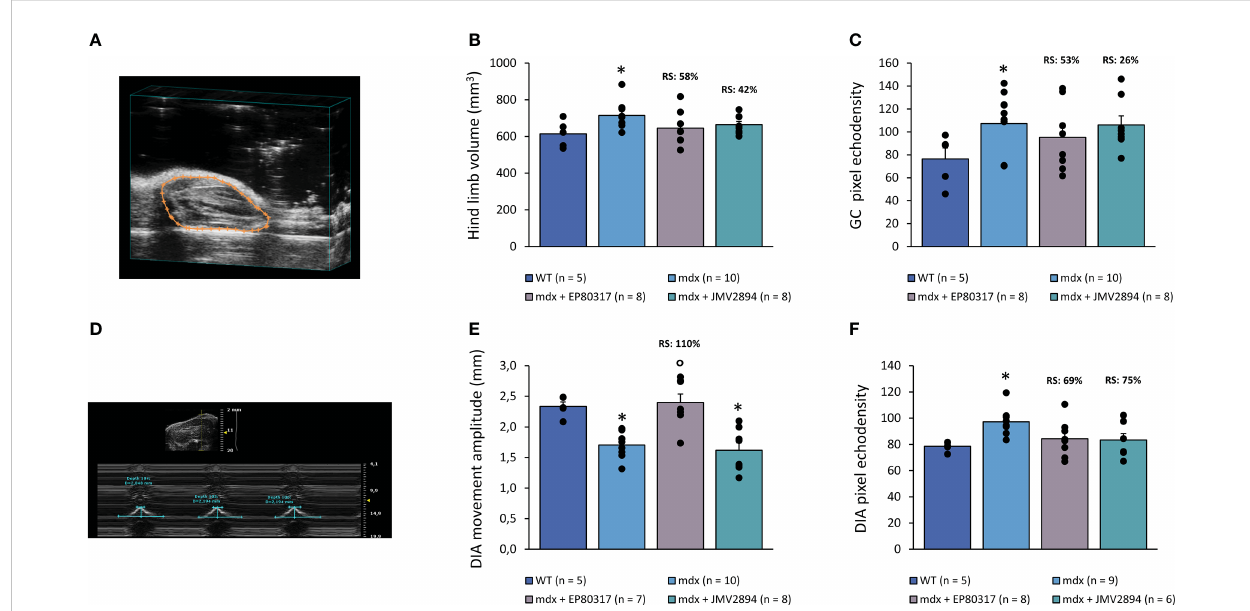
relaxation time (HRT). The treatment with EP80317 or JMV2894 markedly improved both parameters, with high recovery scores (Figure 3A). In parallel, untreated mdx DIA showed a lower Hz50 compared to WT. This index, together with TTP and HRT may be related to altered Ca 2+ homeostasis characterizing dystrophic muscles. Interestingly, both compounds recovered Hz50 (RS: 153% for EP80317, 66% for JMV2894) corroborating a potential ability to ameliorate Ca 2+ handling (Figure 3B). As expected,